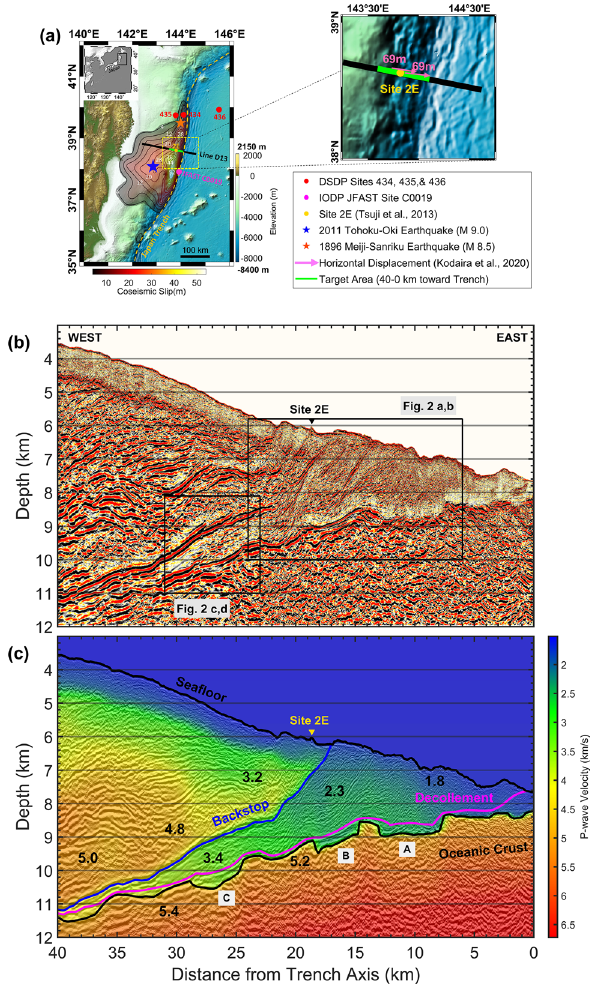
Figure 1. Study area in the Japan Trench. ( a ) Survey map of the 2D seismic line D13 (black line), target area within 40–0 km distance toward the trench (green line), site 2E from previous seafloor observations 15 (yellow circle), epicenter of the 2011 Tohoku-Oki earthquake (blue star), the 2011 coseismic slip calculated by tsunami waveform inversion 5 (color-shaded contour lines), epicenter of the 1896 Meiji Sanriku tsunami earthquake (orange star), Deep Sea Drilling Project (DSDP) sites 434, 435, and 436 (red circles), and IODP JFAST drilling site C0019 (magenta circle). A zoomed rectangular view around the target area shows the location of 69 m seafloor displacements (magenta arrows) due to the 2011 Tohoku-Oki earthquake 17 . ( b ) RTM section of line D13 within a range of 40–0 km distance. ( c ) P-wave velocity model and major horizon interpretations overlaid on the RTM image of line D13. Reflection from backstop interface (blue line) sets the boundary between deformed sediments in the wedge-shaped low-velocity zone and undeformed structures of the upper plate. Top of the oceanic crust (black line) marks the sharp basement of the horst-and-graben structure, and the decollement (magenta line) indicates the plate boundary fault. Grabens marked with capital letters A, B, and C are discussed in the main text. Numbers printed in black across the image are representative V p values in